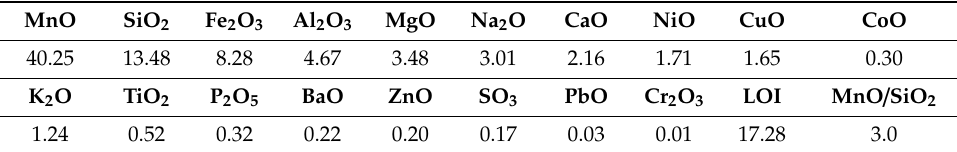
Table 1. Chemical composition of the nodules